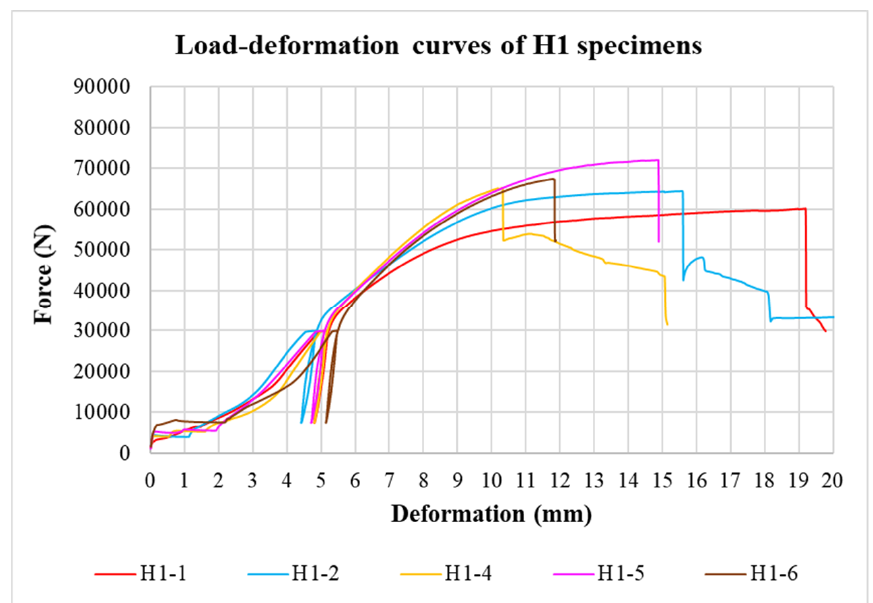
Figure 11. Load-deformation curves of H1 specimens. Table 3. Results of the experimental testing of K2